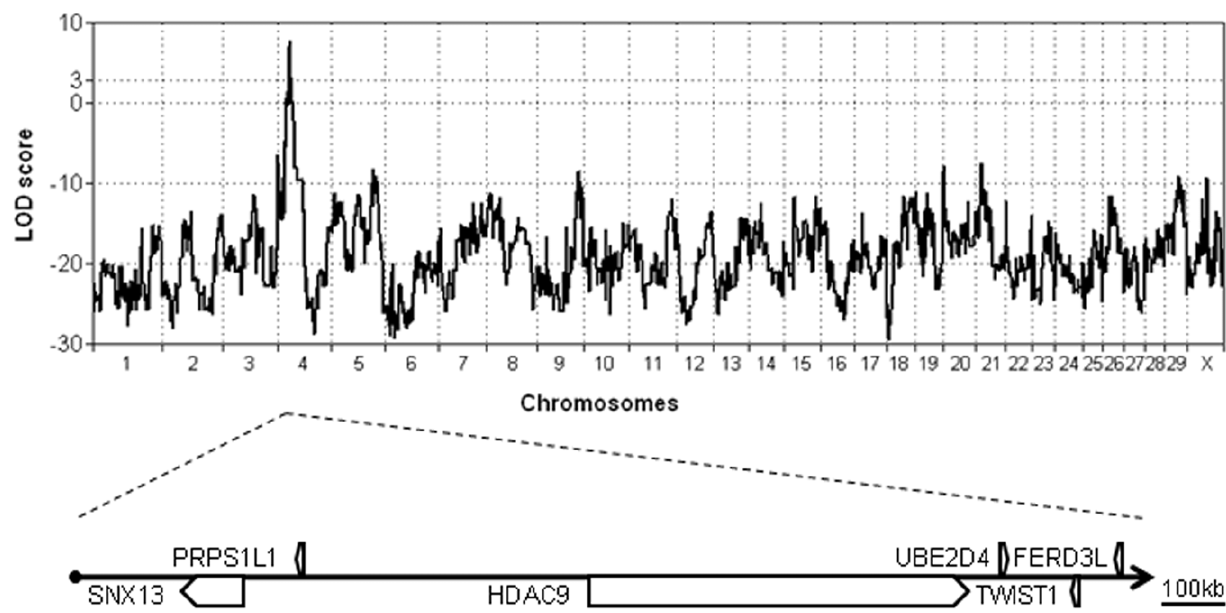
Figure 4. Genome-wide multipoint linkage analysis of type 2 scurs syndrome. The genome-wide scan reveals a significant linkage (maximum LOD score=7.2) with clusters of markers located on chromosome 4. The 95% confidence interval spans 1.7 Mb encompassing six different genes.